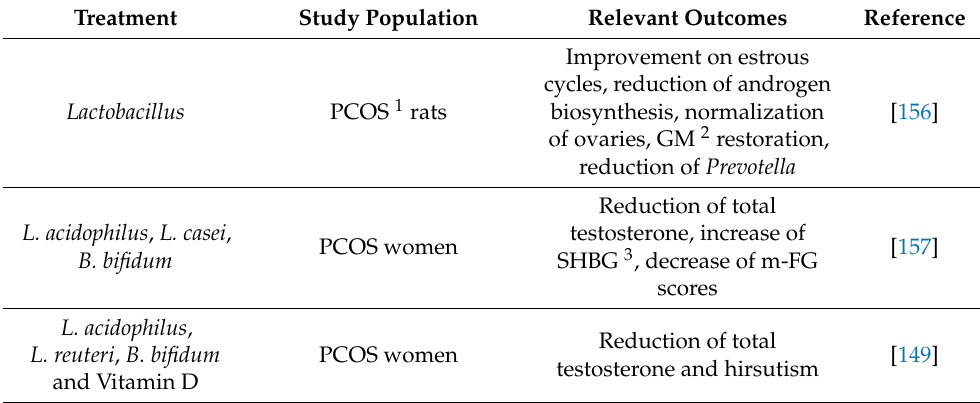
Table 1. Probiotic treatments and the hirsutism-relevant